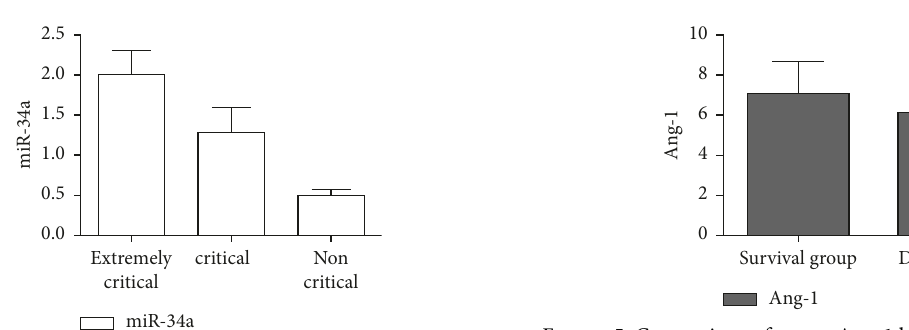
Figure 5: Comparison of serum Ang-1 levels in children with RDS with different prognosis.